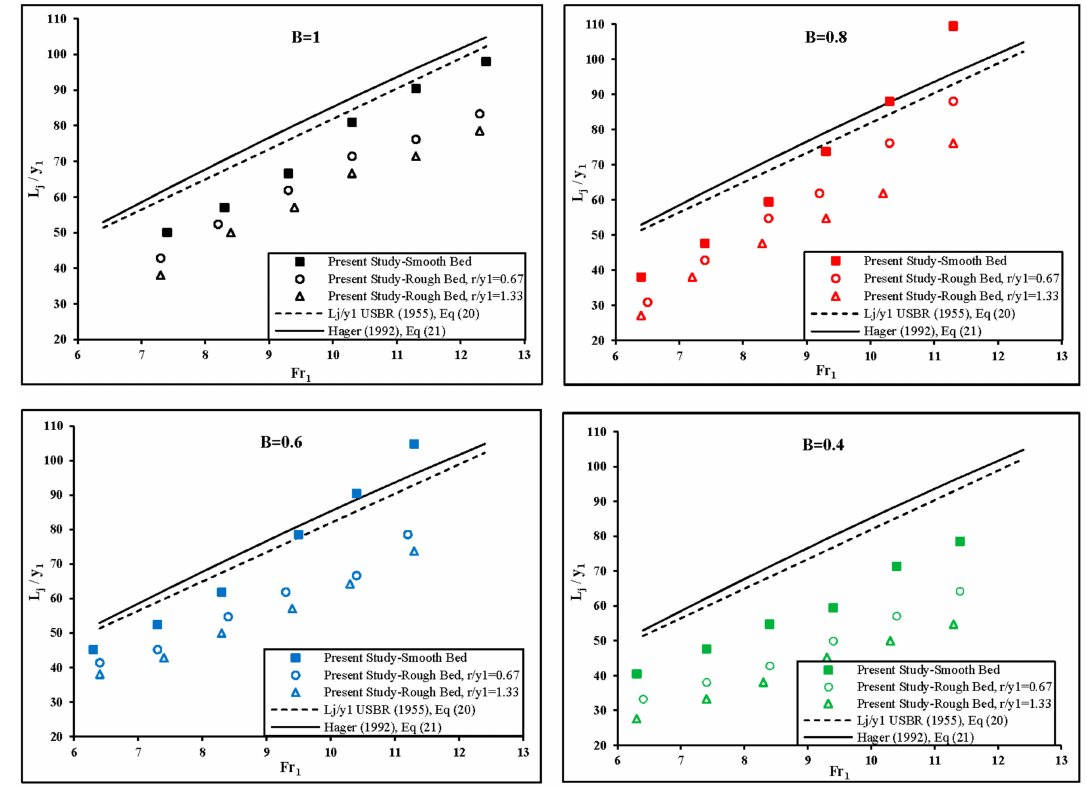
Figure 11. Variation of the relative length of the hydraulic jump ( L j / y 1 ) vs. the inflow Froude number for different divergence ratio ( B = 1, 0.8, 0.6 and 0.4) and two relative height of dissipative elements ( r / y 1 = 0.67 and 1.33).